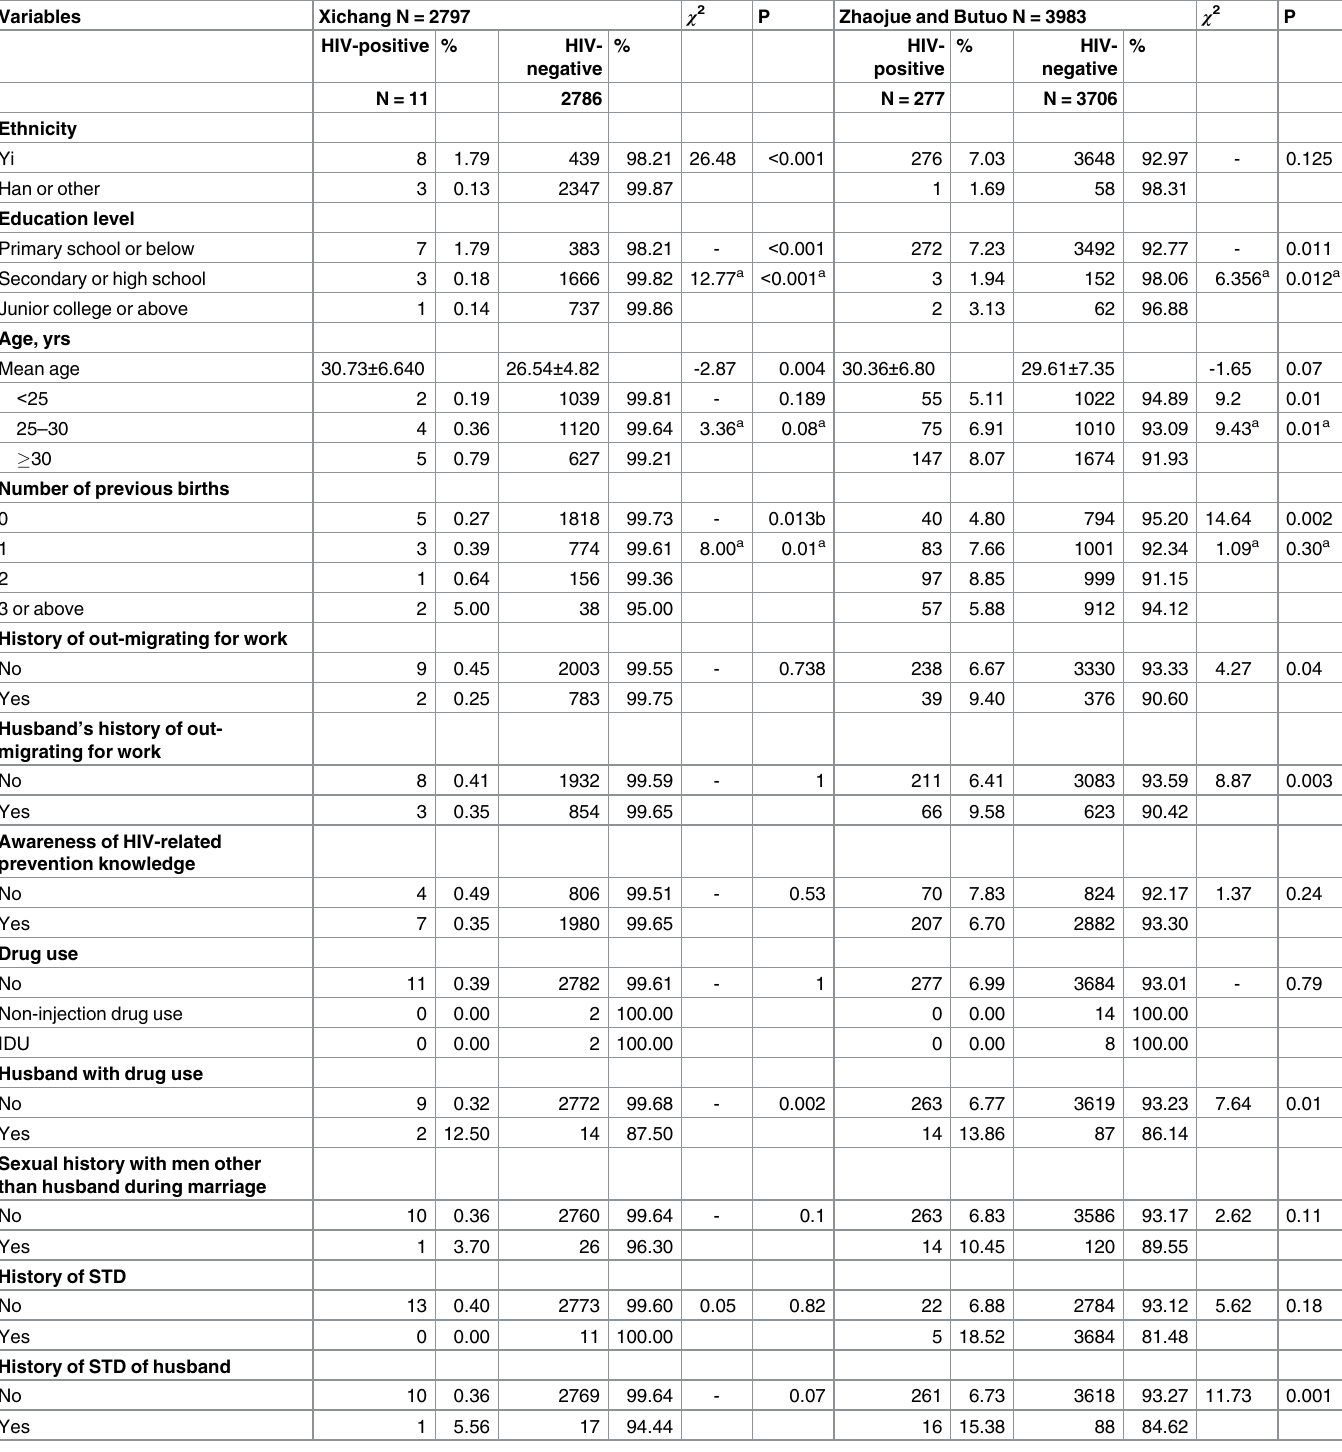
Table 1. Demographic characteristics, awareness of HIV-related prevention knowledge, and behavioral characteristics of included